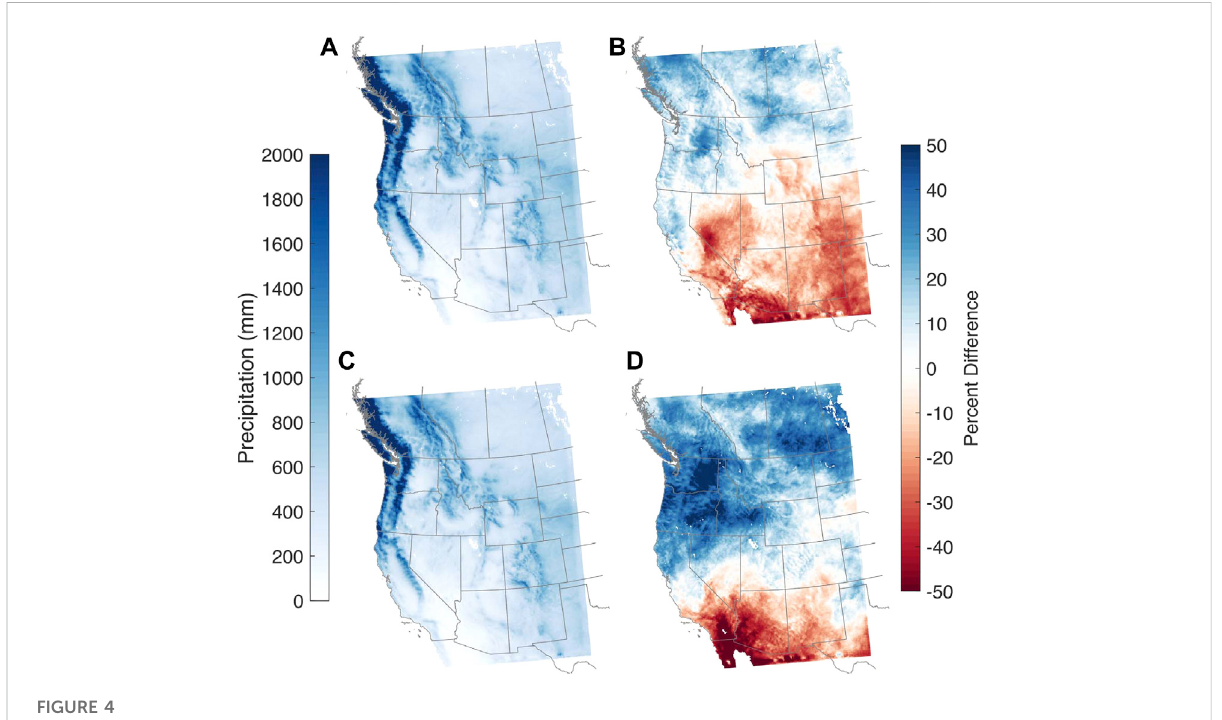
FIGURE 4 Decade-averagedannualprecipitationfor (A,C) historicaldecadeand (B,D) percentdifferencebyend-centuryfrom (A,B) WRF/CCSMand (C,D)